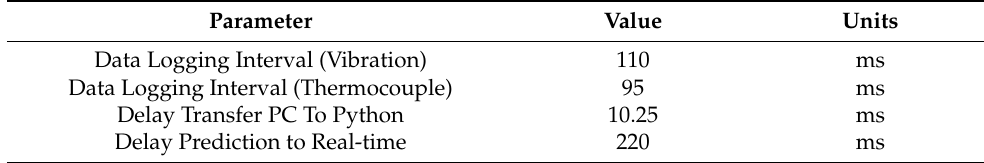
Table 5. Time parameter for data sampling.